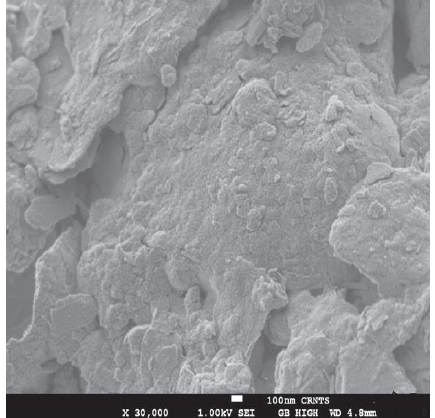
Figure 5: Scanning electron micrograph. of Biskra Dune Sand (higher magnitude).